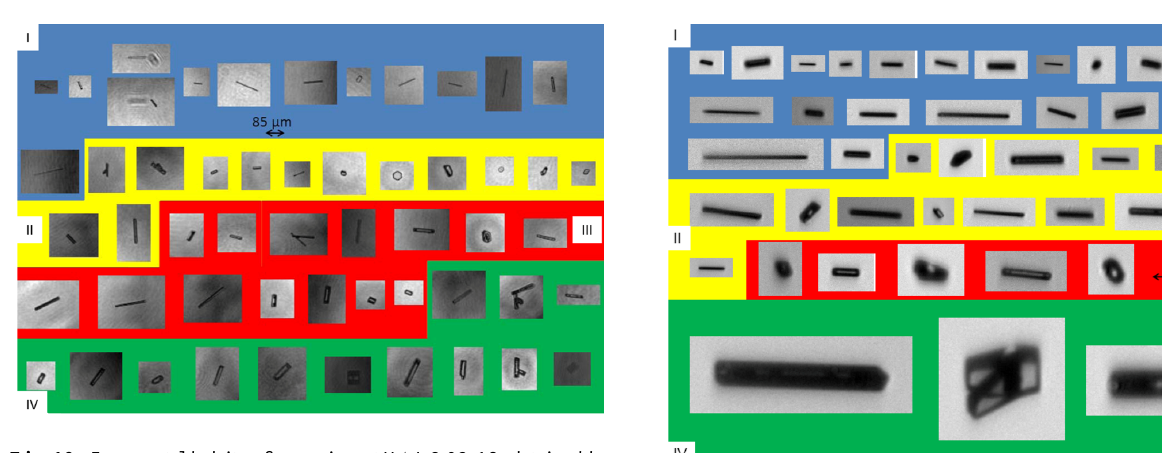
Fig. 10. Ice crystal habits of experiment HALO02 18 obtained by Figure 10. Ice crystal habits of experiment HALO02_18 obtained by HOLIMO during four 3 HOLIMO during four different time slots showing phases of habits different time slots showing phases of habits and frequency of occurrences throughout the 4 and frequency of occurrences throughout the experiment. experiment. 5